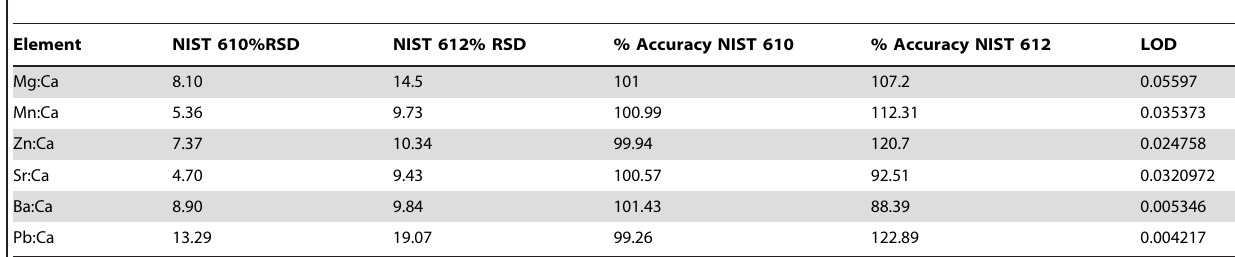
LOD are given in mmol mol –1 . Values for %RSD (% relative standard deviation) and % accuracy.